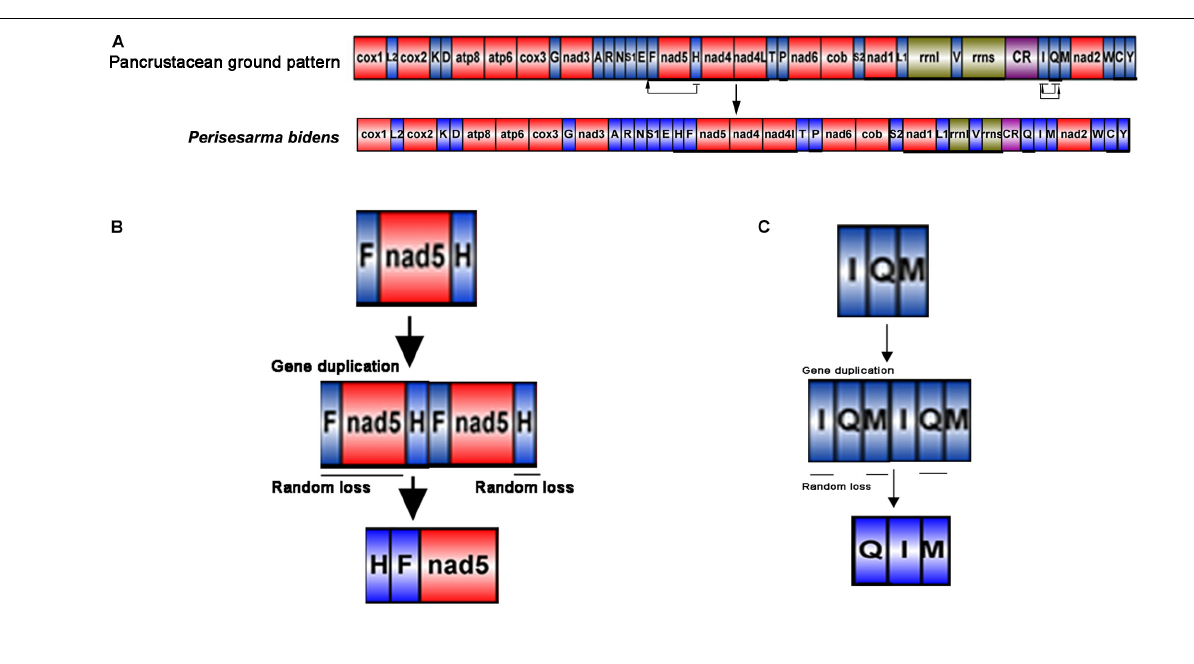
FIGURE 4 | Generation of the P . bidens mitochondrial gene arrangement. The duplication/random loss, recombination, and duplication/non-random loss models were used to explain the principle of gene rearrangement. (A) Comparison of gene order in mitogenome of Perisesarma bidens and Pancrustacean ground pattern. tRNA genes are indicated by the singer letter IUPAC-IUB abbreviation with S1 = AGN, S2 = UCN, L1 = CUN, and L2 = UUR, where as protein and rRNA genes are labled with three letter codes. (B) Gene duplication occurred in trnF , nad5 , and trnH , changing the arrangement of trnF - nad5 - trnH to trnF - nad5 - trnH - trnF - nad5 - trnH . Then, the redundant trnF , nad5 , and trnH genes were lost at random. Finally, the new gene order of trnH - trnF - nad5 was formed. (C) Gene duplication occurred in trnI , trnQ , and trnM , changing the arrangement of trnI - trnQ - trnM to trnI - trnQ - trnM - trnI - trnQ - trnM . Then, the redundant trnI , trnM , and trnQ genes were lost at random. Finally, the new gene order of trnQ - trnI - trnM was